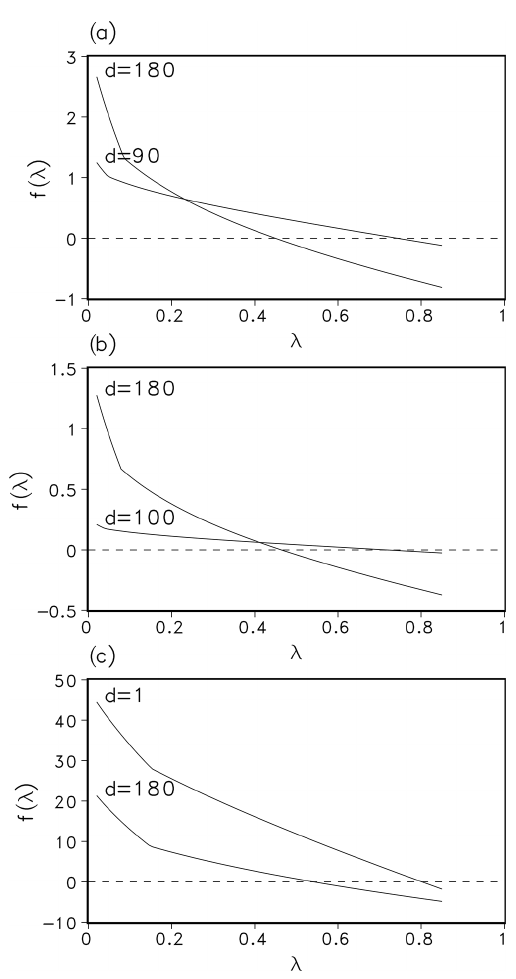
Figure 1. Function f (λ) for a set of parameters from different days in 1901 and locations, namely Hainich (Germany, mixed-temperate forest; (a) , Seiteminen (Finland, boreal forest; (b) , and Santarem (Brazil, tropical rainforest; (c) . Panel (d) denotes the day in year